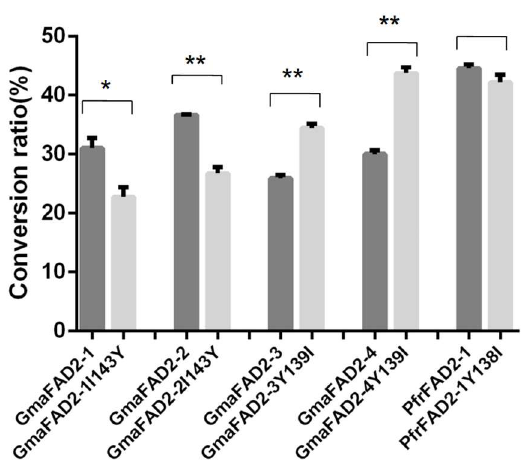
Figure 6. The conversion of oleic acid into linoleic acid in S. cerevisiae cells overexpressing the GmaFAD2 and PfrFAD2-1 genes through the site 143 mutation of GmaFAD2-1. The conversion ratios were calculated based on the results of GC shown in Figure S5 in File S3. The * means p < 0.05 and the ** represents p <